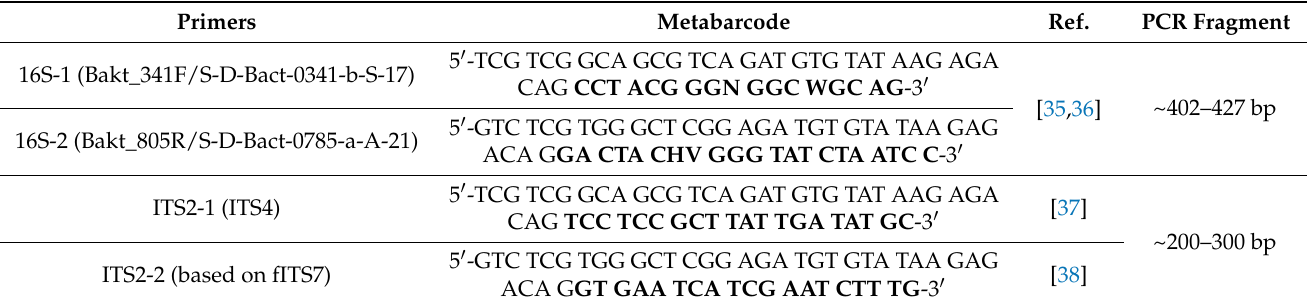
Table 1. Set of primers used for species identification. PCR primers used for generation of amplicons of metagenomic sequencing libraries of bacteria (16S) or fungi (ITS2). Illumina adapters were added to the original sequence; the priming sequences are highlighted in bold. Metabarcode